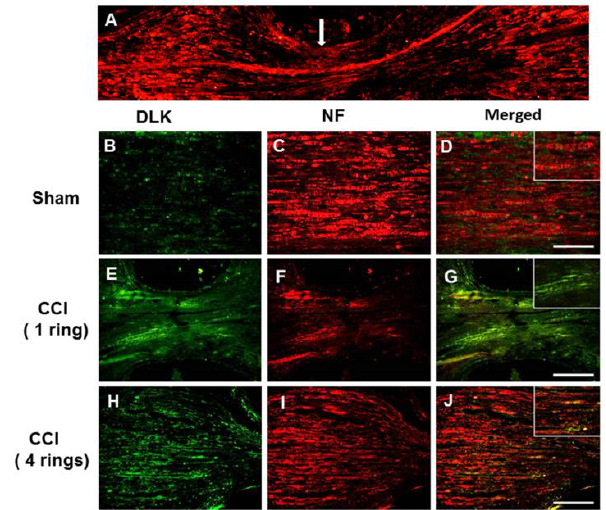
Figure 1. Representative dual leucine zipper kinase (DLK) and neurofilament (NF) expression over the injury site of the nerve in chronic constrictive injury (CCI) animals four weeks after injury. ( A ) Distribution of DLK distal and proximal to the point of CCI injury. ( B ) Distribution of DLK in the proximal site of the sham group. ( C ) Co-localized with Neurofilament. ( D ) Merged imaging fusion of ( B , C ), right upper box indicated the imaging amplification. ( E ) Distribution of DLK in the proximal site of one ring CCI. ( F ) Co-localized with Neurofilament. ( G ) Merged imaging fusion of E and F, right upper box indicated imaging amplification. ( H ) Distribution of DLK in the proximal site of four rings CCI. ( I ) Co-localized with Neurofilament. ( J ) Merged imaging fusion of ( H , I ), right upper box indicated imaging amplification. Bar length = 200 µ m; Arrow indicated the nerve crushed region.